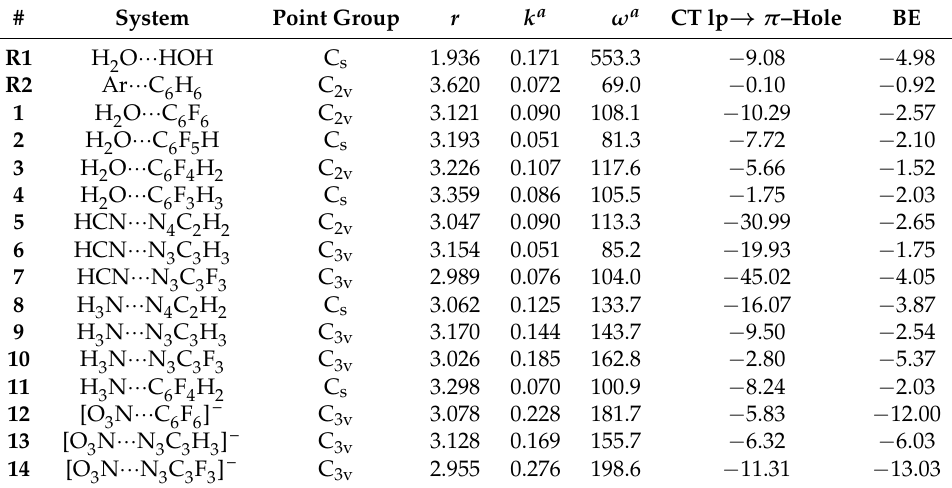
Table 3. Summary of LVM data: π –hole interaction distances r , k a , ω a , charge transfer CT, and BSSE counterpoise corrected binding energies